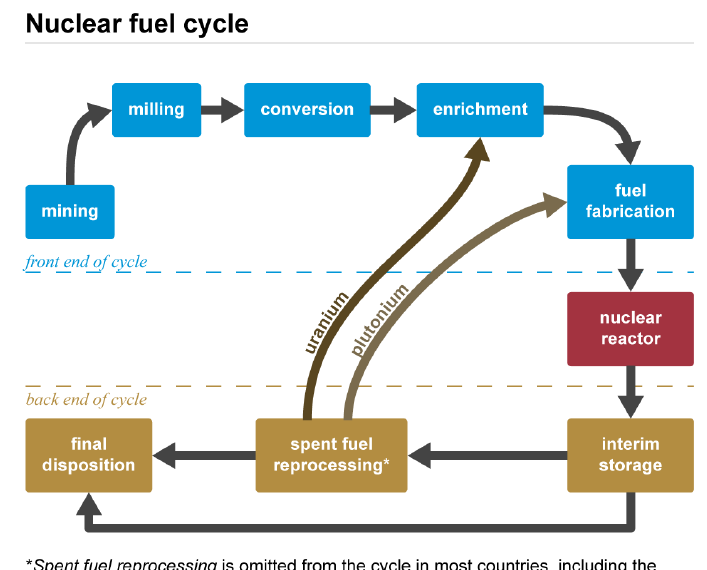
Figure 2. Nuclear fuel cycle. Source: Pennsylvania State University Radiation Science and Engineer- ing Center (public